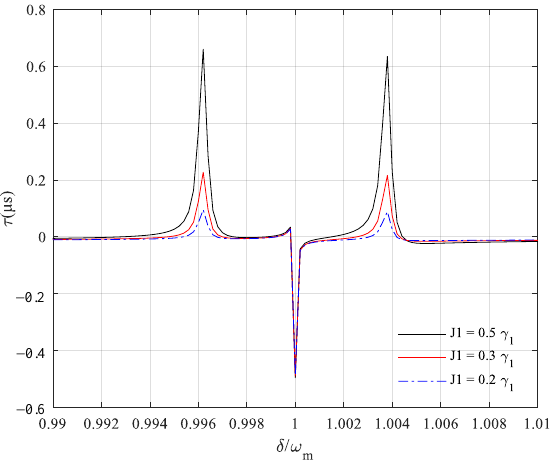
 for different values of Figure 6. Group delay τ as a function of the probe detuning δ / ω m for different values of tunneling Figure 6. Group delay  as a function of the probe detuning m strength J 1 . J 1 = 0.5 γ 1 (black, solid curve); J 1 = 0.3 γ 1 (red, dashed curve); J 1 = 0.2 γ 1 (blue, J . 0.5 J = (black, solid curve); 0.3 J = (red, dashed curve); 0.2 J = tunneling strength 1 1 1 1 1 1 1 dash-dotted curve). χ = 5 × 10 − 9 γ 1 , and the other parameter values are the same as in Figure 5 10   − =  , and the other parameter values are the same as in Figure (blue, dash-dotted curve). 9 1 5.